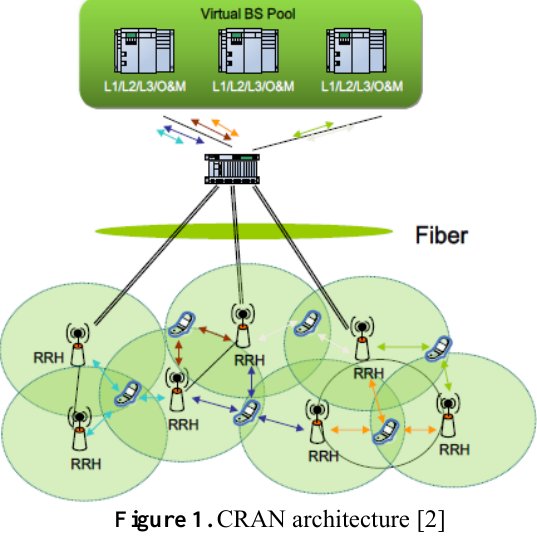
Figure 1. CRAN architecture [2]